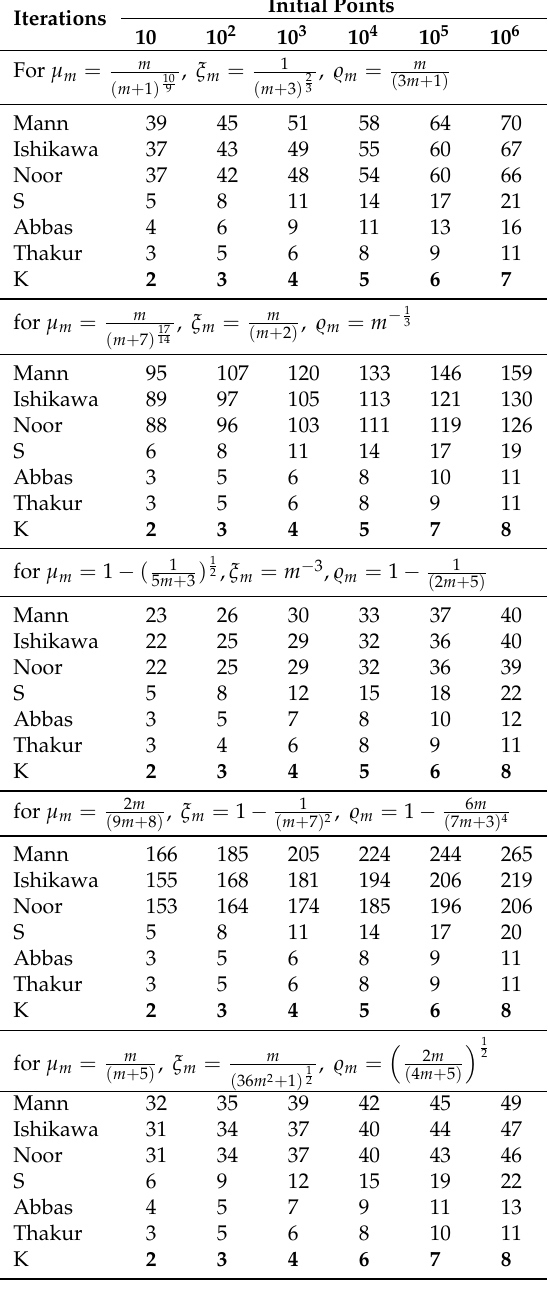
Table 2. Influence of parameters: comparison of various iterative